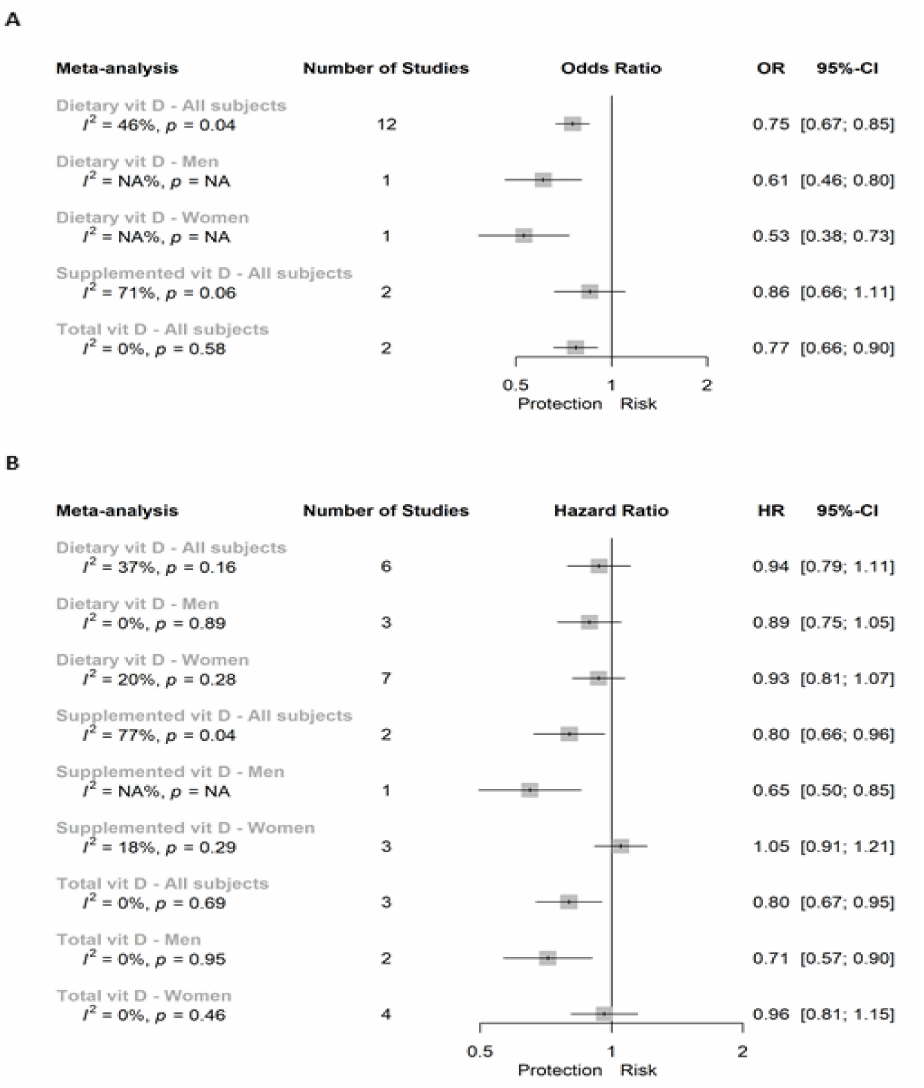
Figure 2. Super plot of ( A ) case-control and ( B ) prospective cohort studies assessing the association between vitamin D intake (highest versus lowest categories) and the risk of colorectal